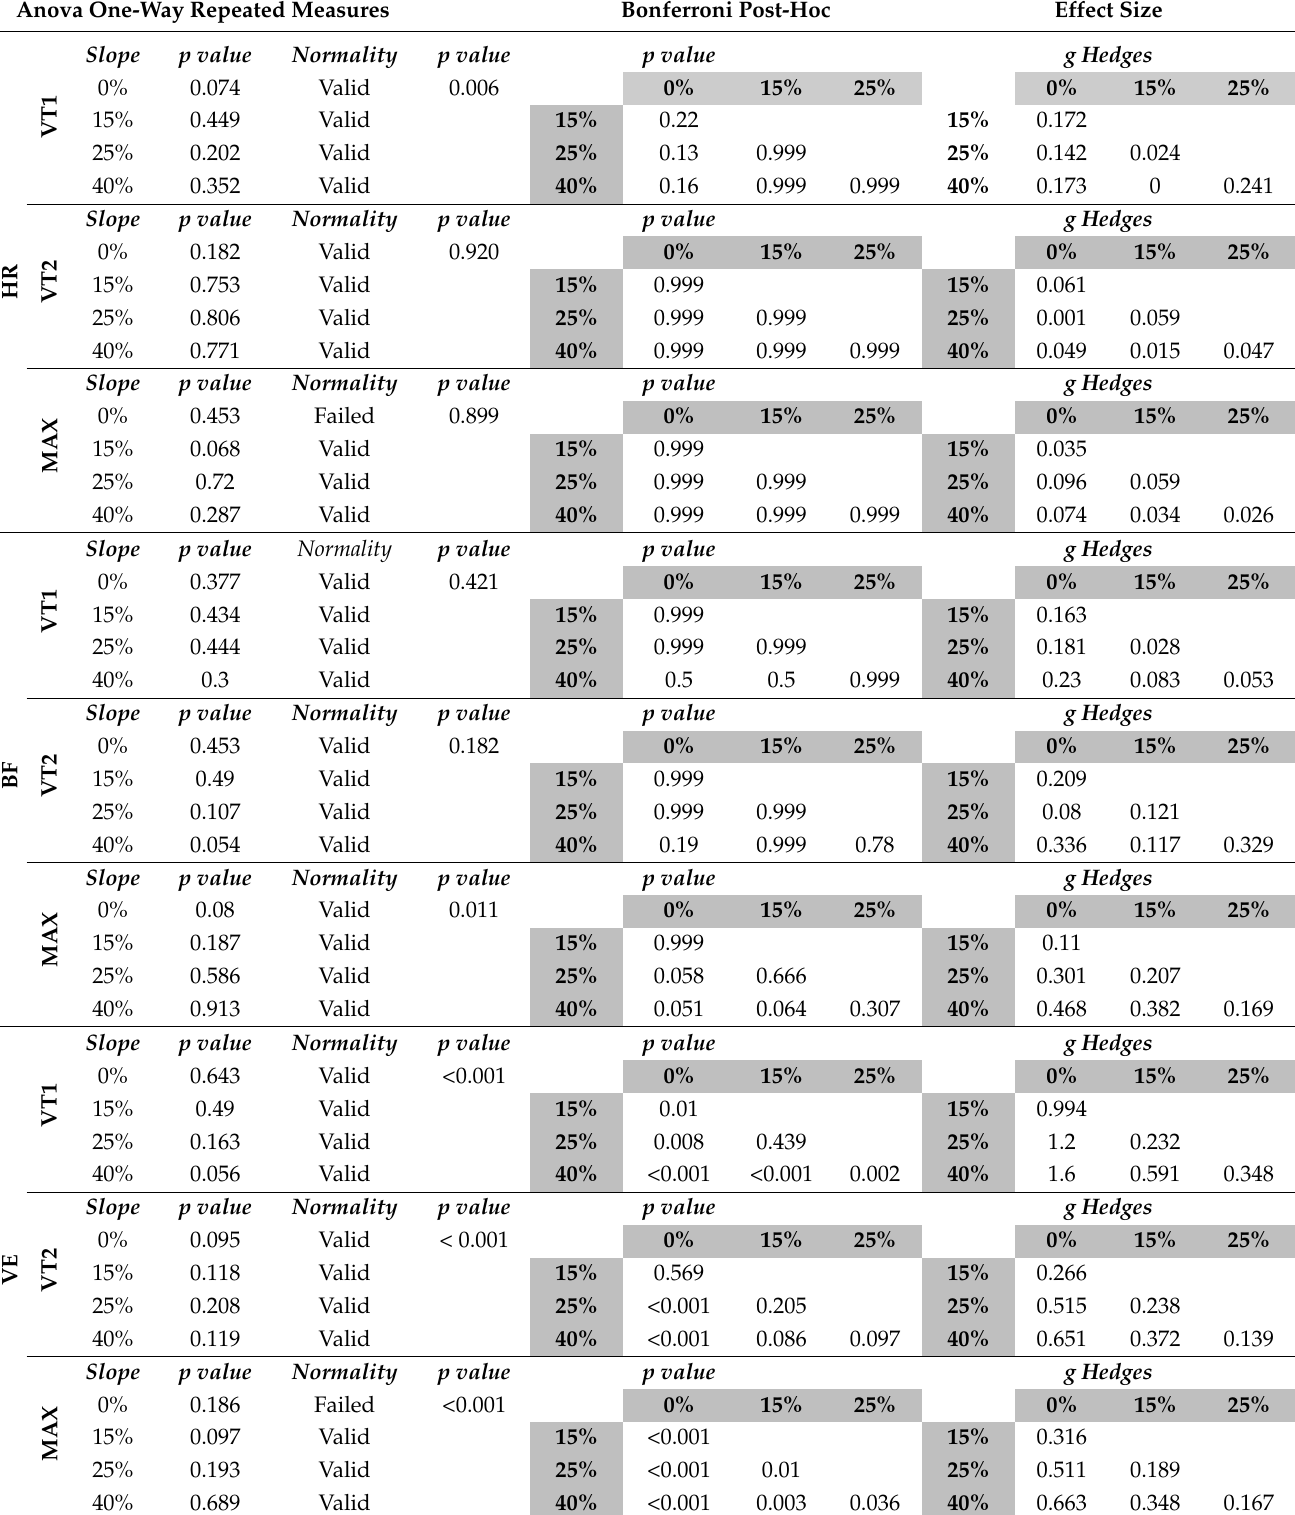
Table 2. Results of statistical analysis including Shapiro–Wilk test for normality and p value for one-way ANOVA and Bonferroni post-hoc analysis comparing heart rate (HR), breathing frequency . . VE ) and oxygen consumption ( VO 2 ) at all positions (VT1, VT2 and MAX) and (BF), ventilation ( between slope conditions. Effect sizes are presented in right part of the table using Hedges’ g